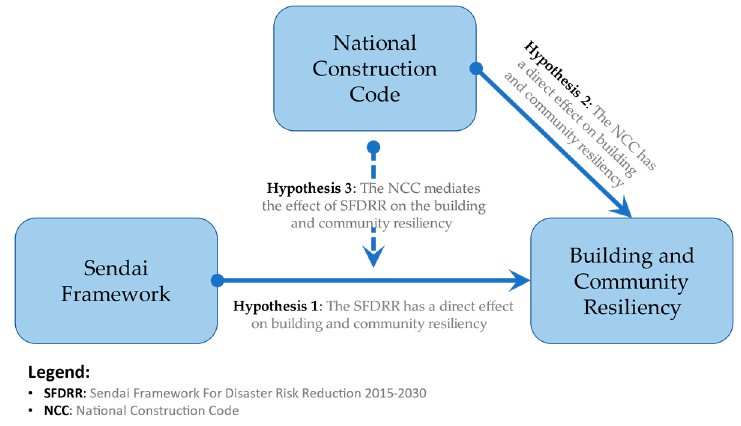
Figure 3. Conceptual Framework.